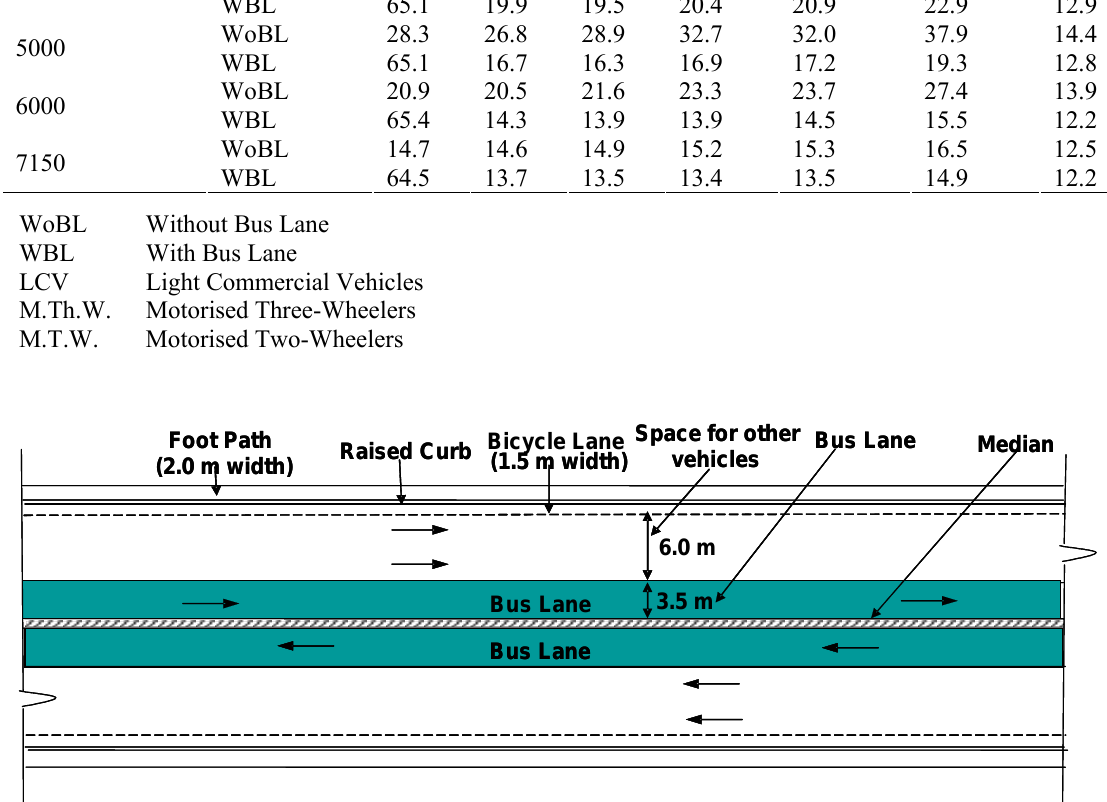
Figure 9. Schematic layout of the road stretch with exclusive bus